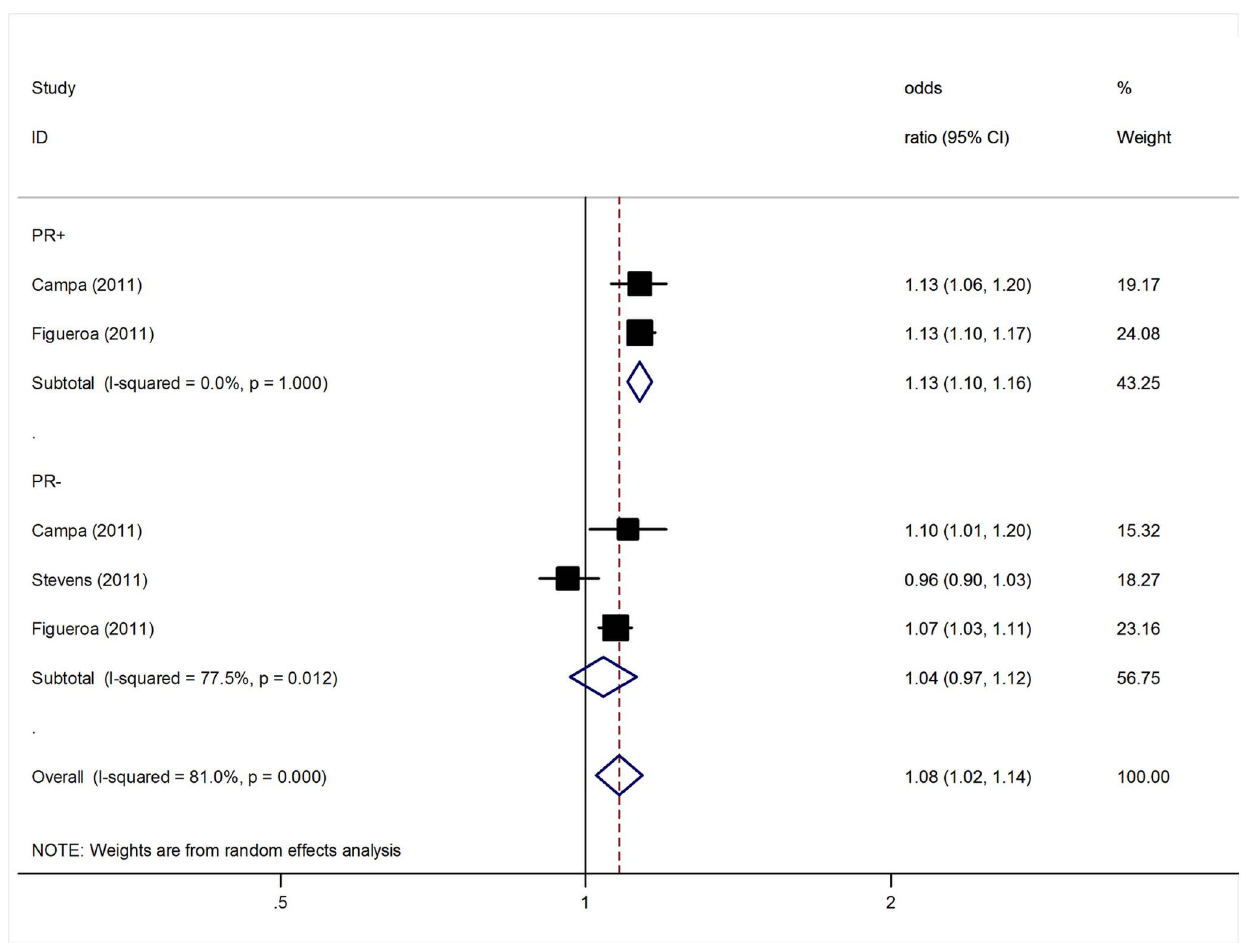
Figure 3. Per-allele odds ratios and 95% confidence intervals for the association between 1p11-rs11249433 and BC risk by PR status.